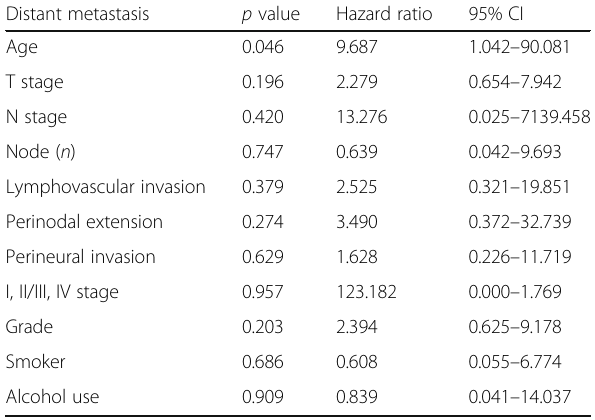
Table 3 Multivariate analysis of risk factors for overall survival Survival